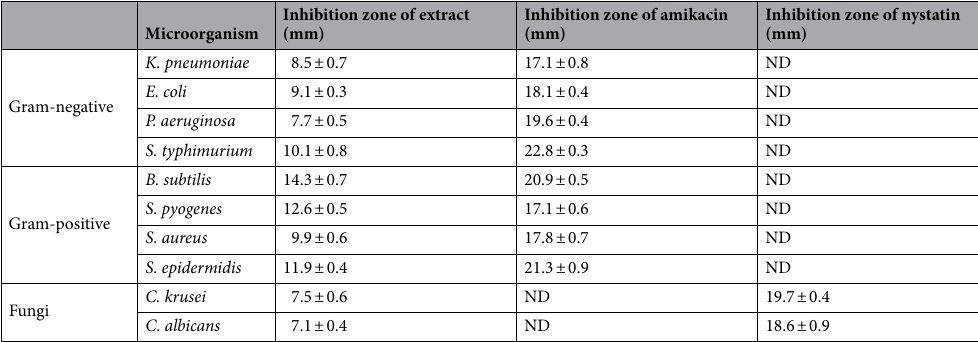
Table 1. Anti-bacterial and anti-fungal activity of A. lividus extract. ND not determined. *Nystatin (30 µg), Amikacin (30